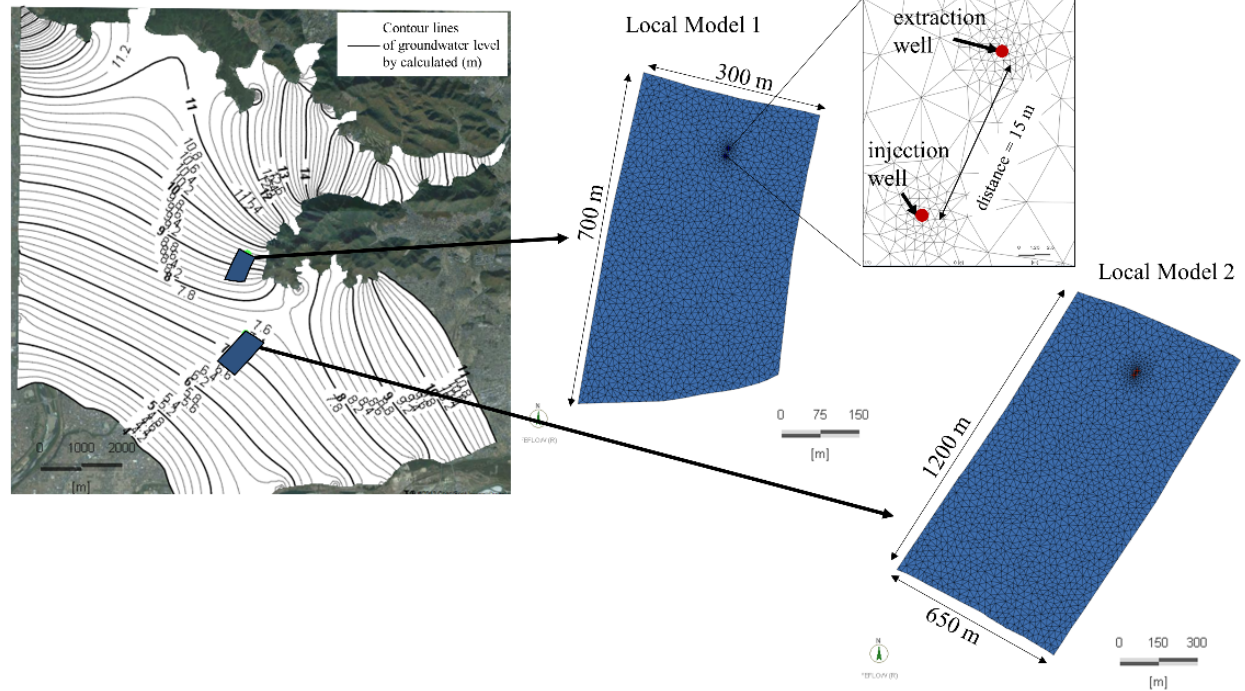
Figure 7. Local simulation models 1 and 2.